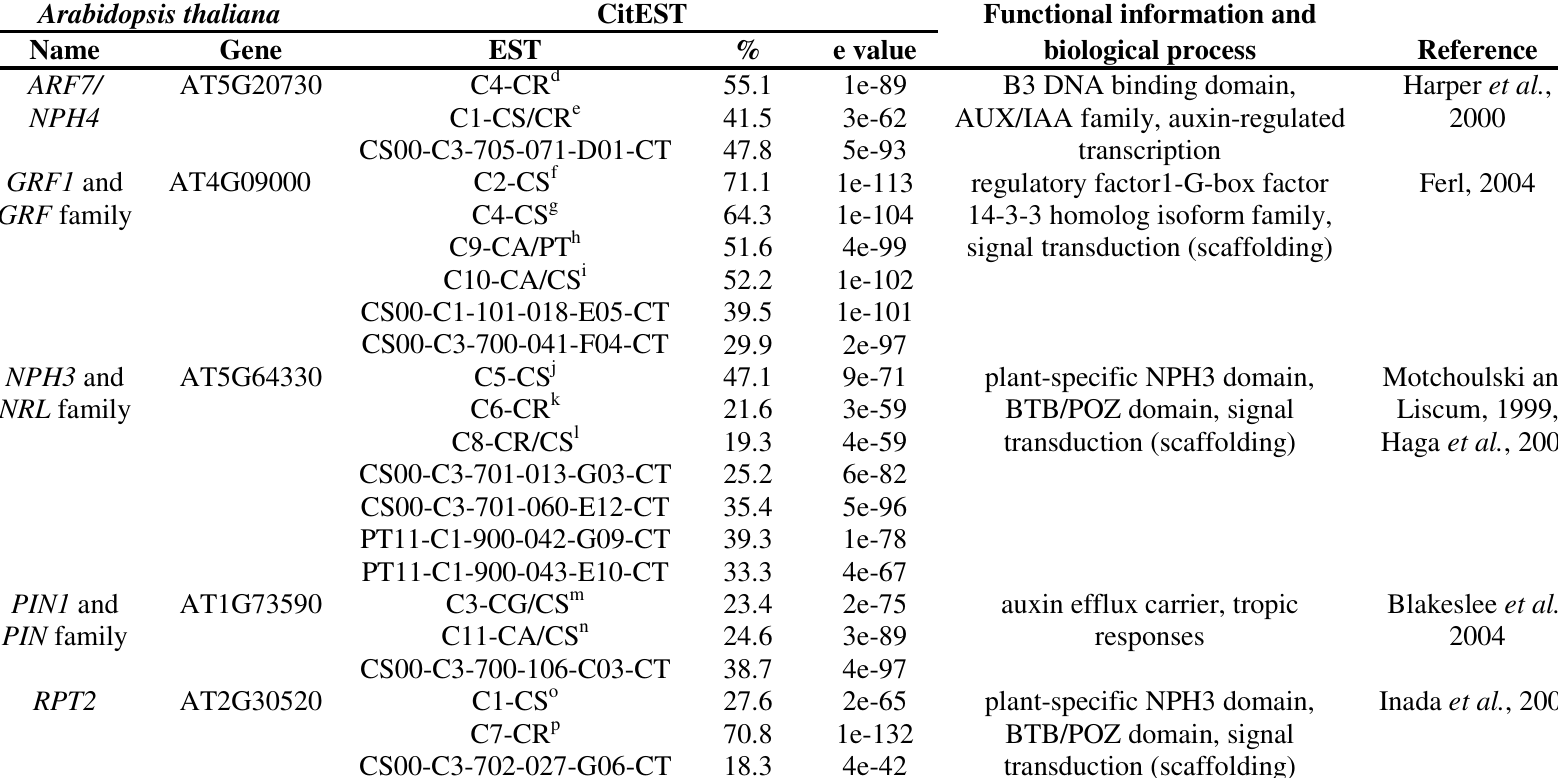
Table S3 . Citrus ESTs with homology to genes involved in phototropin-mediated responses in Arabidopsis thaliana